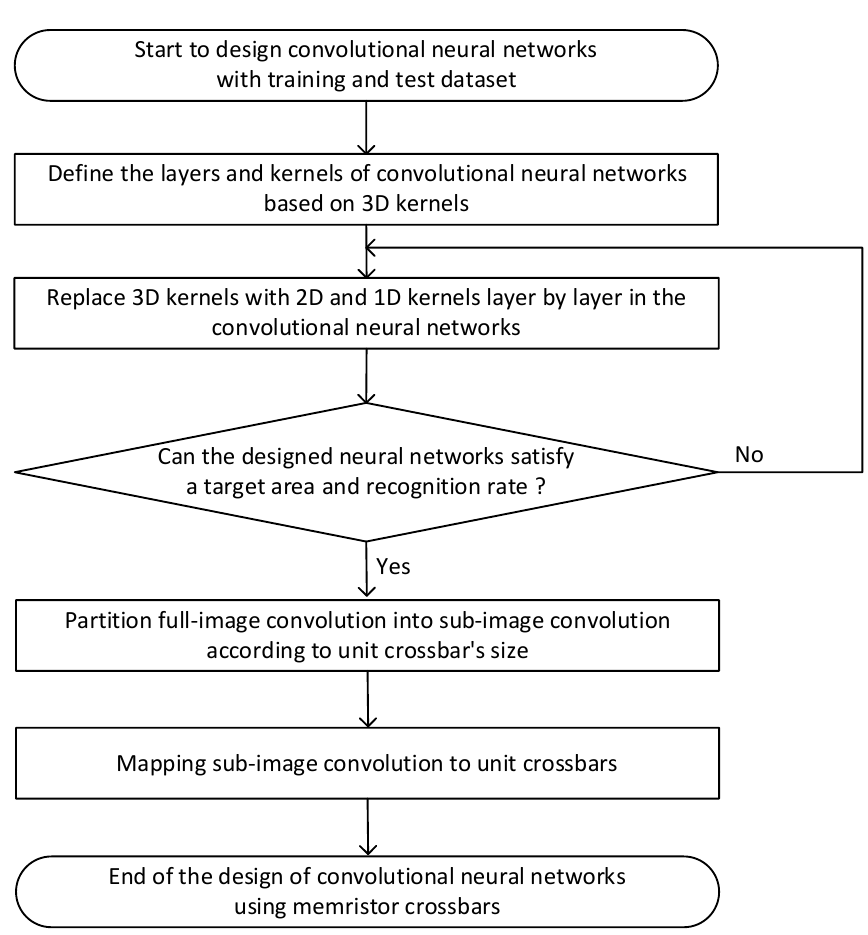
Figure 5. The area-efficient mapping method of convolutional neural networks to memristor crossbars using sub-image partitioning.